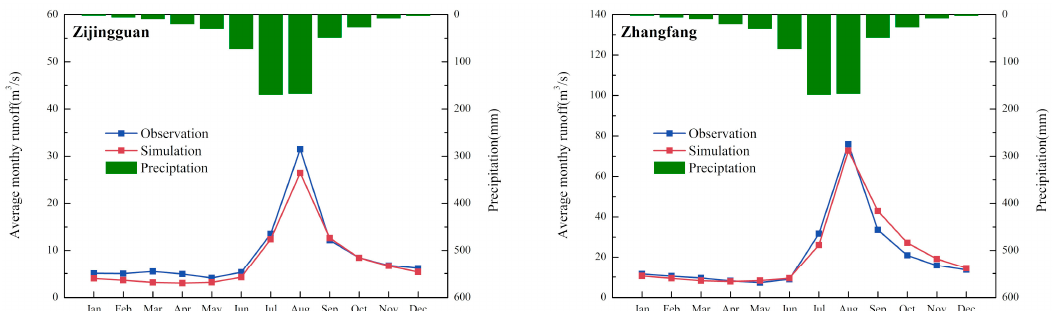
Figure 8. Comparison of the observed runoff and simulated runoff at a monthly scale during the baseline period.